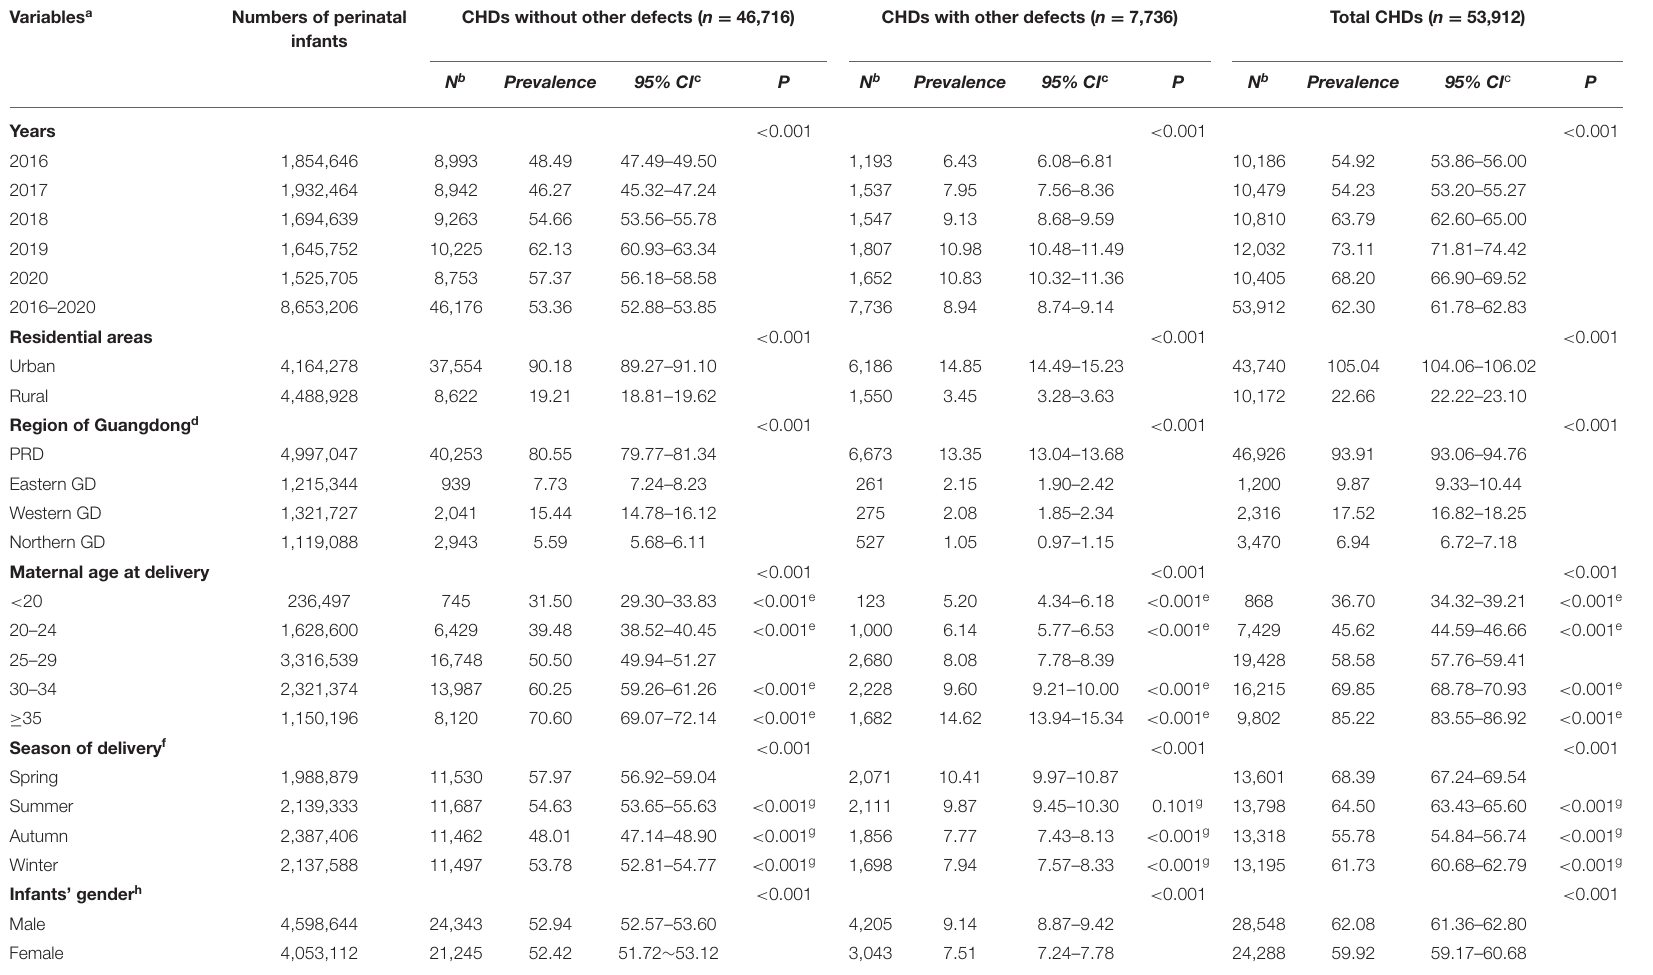
TABLE 1 | Prevalence of congenital heart defects (CHDs) (per 10,000 perinatal infants) in Guangdong, China, 2016–2020. Variables a Numbers of perinatal